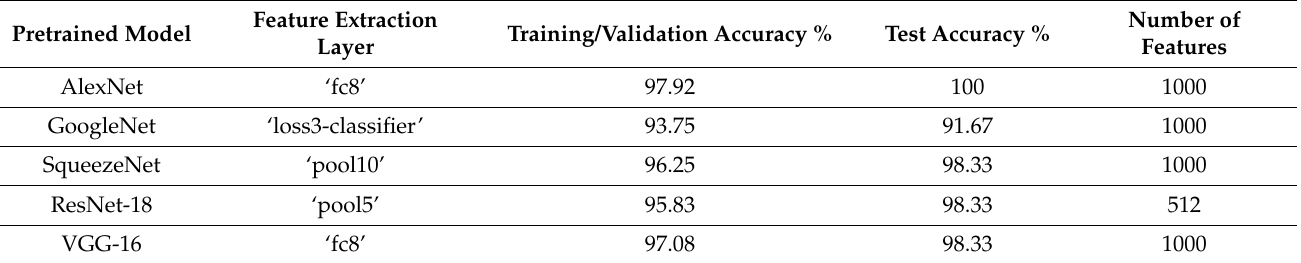
Table 11. Classification performance of SVM using the autonomous features from various pretrained models. Pretrained Model